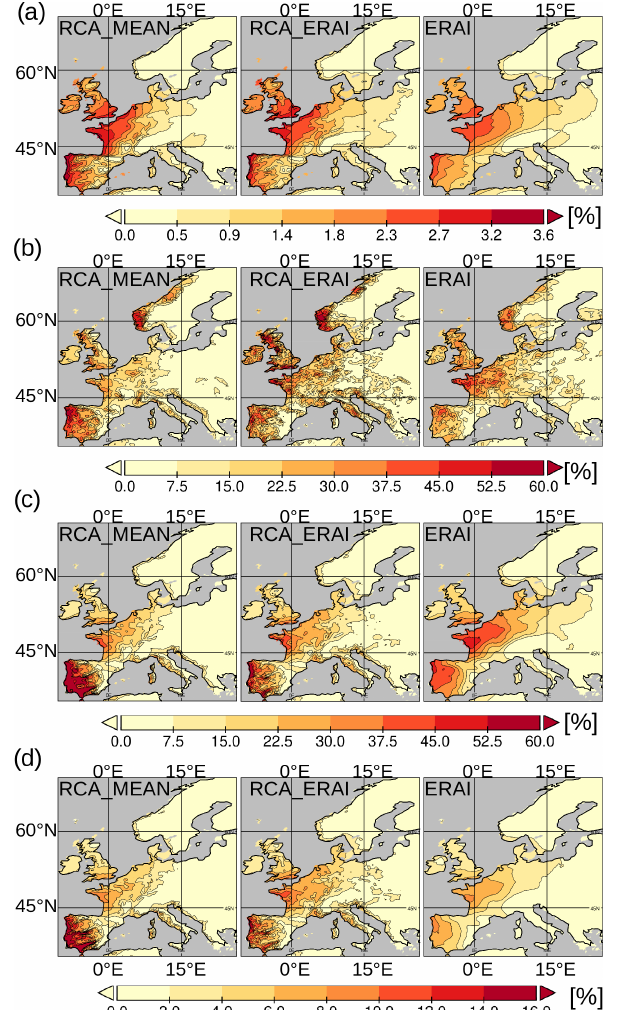
Figure 5. ARF expressed as the total number of days a grid cell was covered by an AR during the historical period. (b) Percentage of the annual maximum precipitation related to ARs (%AMP). (c) Frac- tional contribution of AR-forced precipitation to the > 95th per- centile precipitation (%95 P ). (d) Same as panel (c) but for the total precipitation